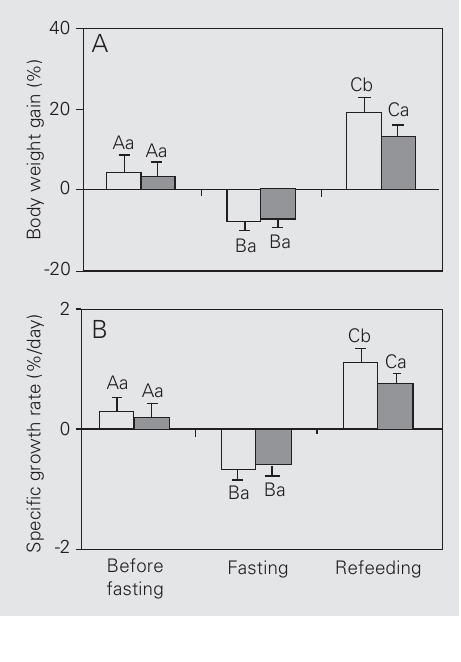
2. Effect of fasting